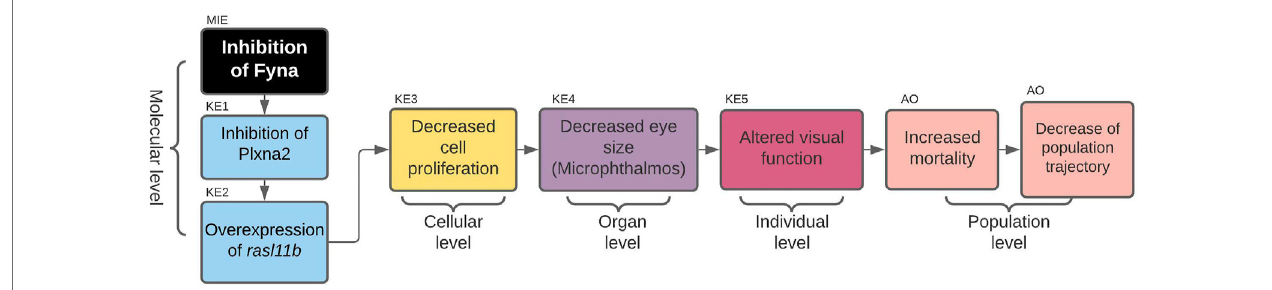
FIGURE 3 | AOP 399. Inhibition of Fyna leads to increased mortality via decreased eye size (microphthalmos).